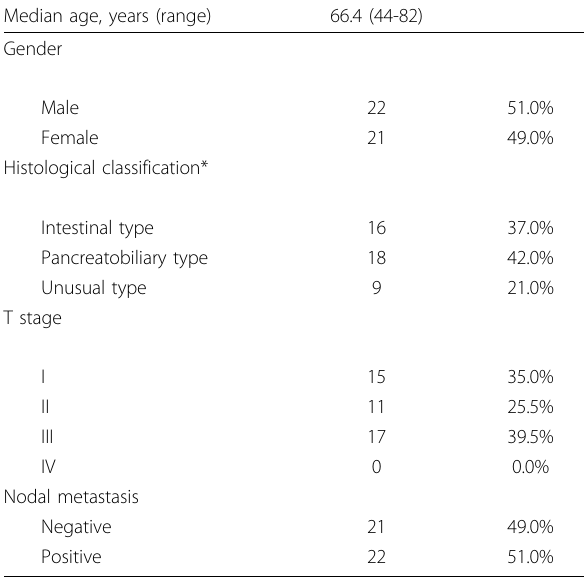
Table 1 Clinicopathological Data of 43